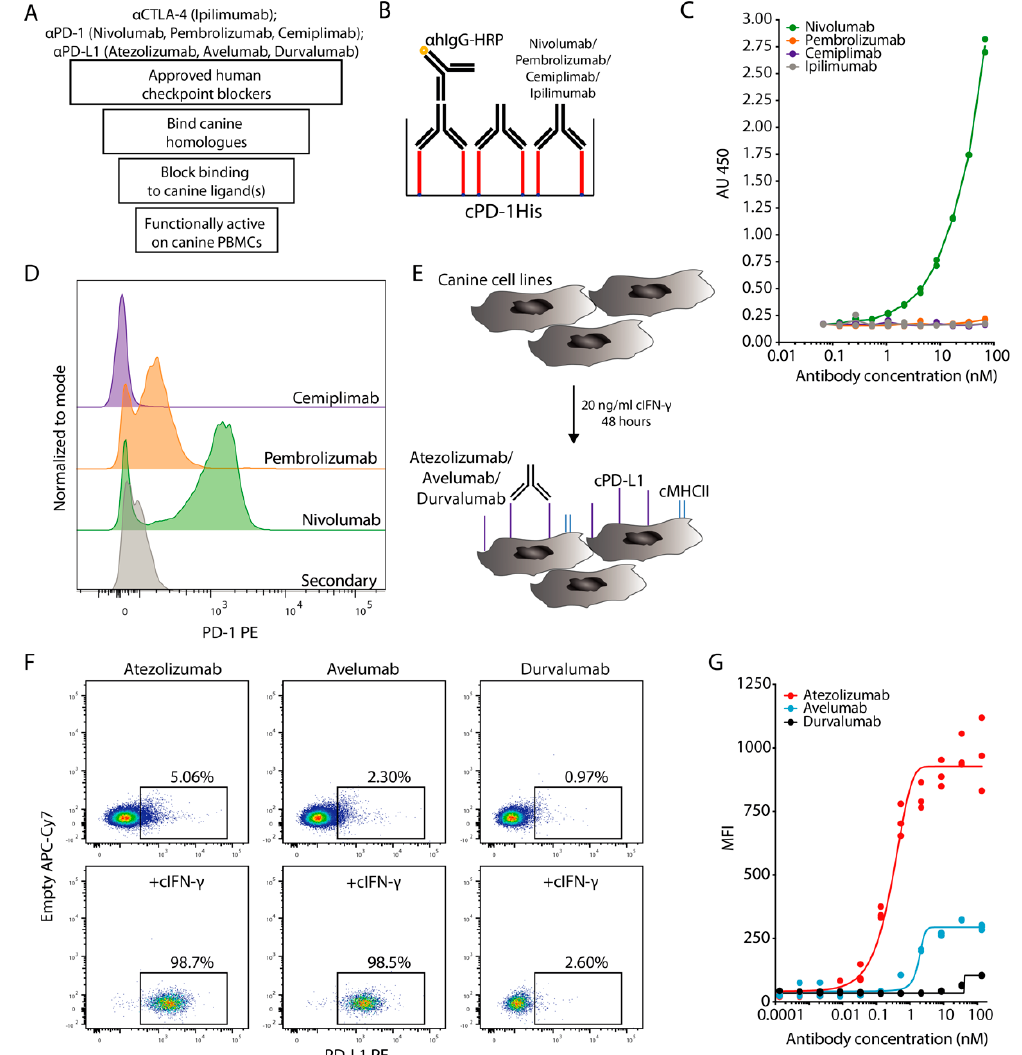
Figure 1. Cross-binding of human ICIs with canine homologues. ( A ) Schematic workflow for the evaluation steps of ICIs in dogs. ( B , C ) Plate-based assay to determine cPD-1 binding by nivolumab, pembrolizumab and cemiplimab was performed by coating 10 µ g/mL of cPD-1His (red) on a microwell plate and incubation with various concentrations of respective ICIs, with ipilimumab acting as a negative control. Subsequently ICI binding was detected with anti-human IgG-HRP. ( B ) Schematic representation of the experiment, ( C ) Duplicates with fitted curve (log agonist versus response). Representative plot from two independent experiments. ( D ) Flow cytometric histograms show binding profiles of nivolumab, pembrolizumab and cemiplimab to canine T cells after 48 h of ConA stimulation. Pregated on Live Single CD45+CD5+ cells. Representative plots from 2 independent experiments ( n = 3). ( E , F ) Flow cytometric evaluation of atezolizumab, avelumab and durvalumab binding cPD-L1 on canine SCC1 cell line stimulated with cIFN- γ . ( E ) Schematic representation of the experiment with upregulation of MHCII (blue) and cPD-L1 (purple) ( F ) Representative flow cytometric plots of cIFN- γ stimulated versus non-stimulated cells. Pregated on Live Single cells. ( G ) MFI binding curve comparison of atezolizumab, avelumab and durvalumab binding to cPD-L1. Triplicates with fitted curve (log agonist versus response). Representative plot from 3 independent ex- periments.